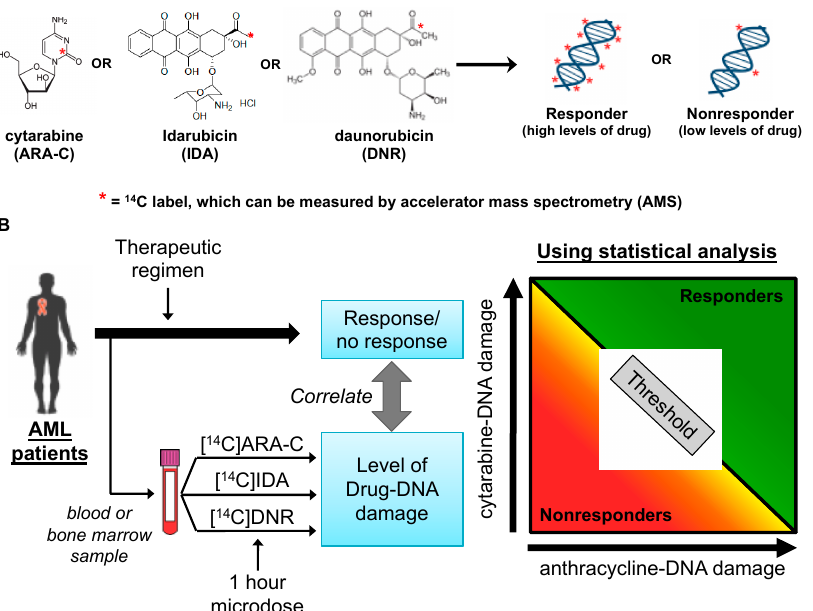
Figure 9. Overview of the ex vivo “diagnostic microdosing” strategy. ( A ) Radiocarbon-labeled cytarabine (ARA-C), idarubicin (IDA), or daunorubicin (DNR) bind to or are incorporated into AML DNA in proportion to the cellular sensitivity to each drug. The resulting drug-DNA “adducts” can be quantified by accelerator mass spectrometry (AMS). ( B ) Strategy for using in vitro microdosing to predict AML patient response to 7 + 3 chemotherapy. Cells isolated from a blood draw or bone marrow (fresh or viably cryopreserved) are briefly exposed to microdoses of each drug (triplicate wells per drug) and assessed by mass spectrometry for quantitation of drug-DNA adduct levels as biomarkers of clinical response to 7 + 3 induction chemotherapy.